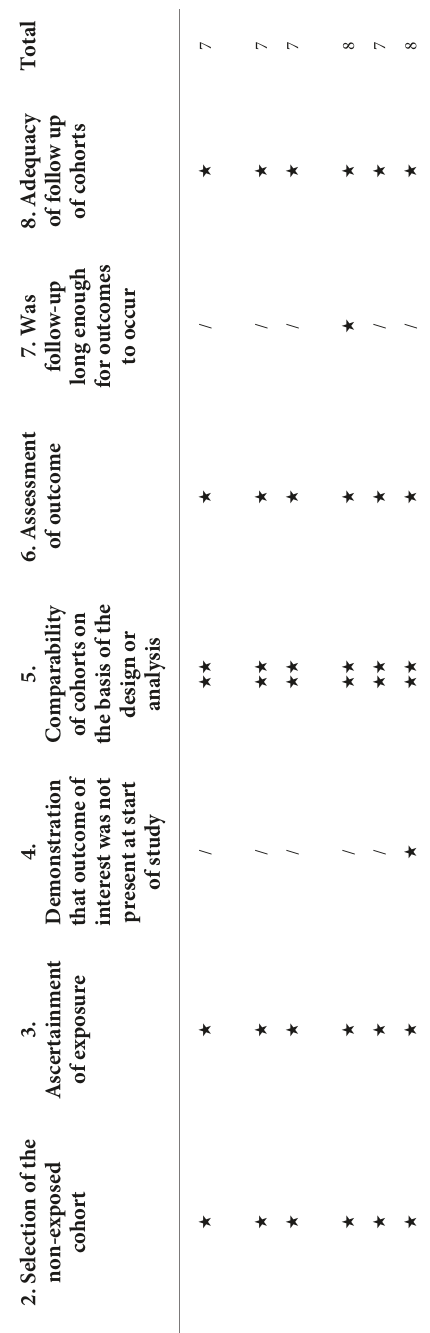
Efficacy outcomes Nucleic acid negative conversion rate Two cohort studies (28, 29) and a RCT (33) reported